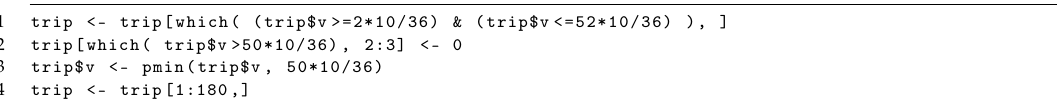
Listing 1. R script for the concatenation at low